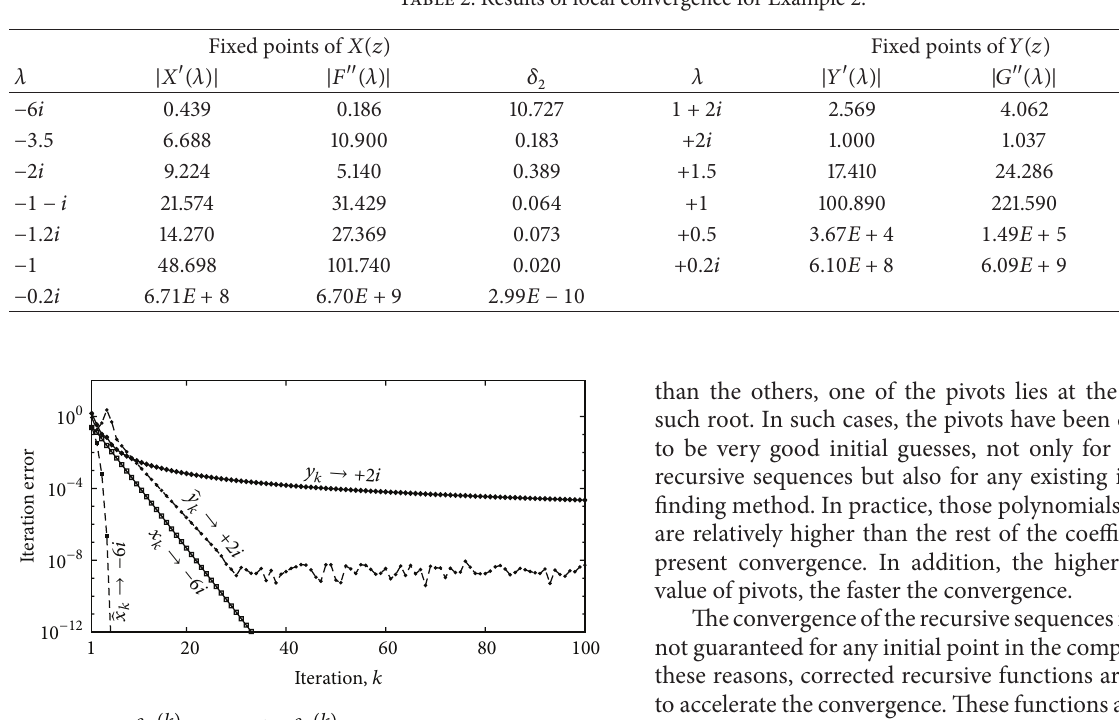
Table 2: Results of local convergence for Example 2.